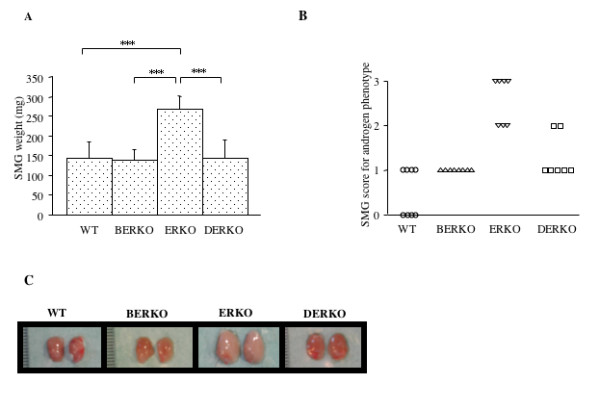
Untreated aged female mice lacking ERα display androgen phenotype of submandibular glands. Untreated 18-month-old WT, ERKO, BERKO, and DERKO mice were used in the experiment. Aged female mice lacking ERα (ERKO) displayed an increased SMG weight (A), size (C) and androgen phenotype (B). One-way ANOVA followed by Fisher's test was used to compare data from mice of different genotypes in (A). Results are presented as mean ± standard deviation. *** P < 0.001